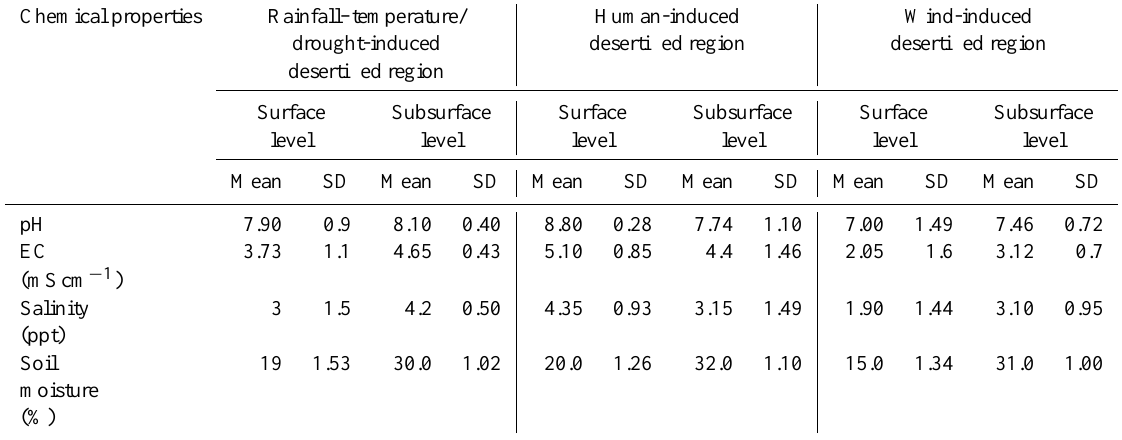
Table 2. Statistical measure of the chemical parameters at sampled locations (33 per region). EC and salinity follow positive correlation with pH in the alkaline range (>7). The moisture content is below 35% in all three zones of desertification. In the drought-affected region the higher salinity is found at the subsurface level because of the fluoride concentration in groundwater. We found that the inverse relationship in human-induced desertified zone, i.e., the surface salinity, is higher than the subsurface and the standard deviation (SD) of surface-level salinity is lesser than the subsurface, which indicates that the human-induced salinity is not fluctuating at surface level because of the constant application of fertilizers for more than 2 decades. A high extent of surface-level soil moisture stress (90%) is observed in the wind-induced desertified